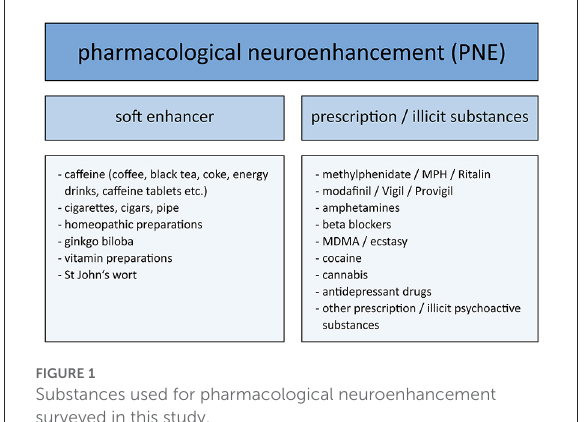
FIGURE1 Substances used for pharmacological neuroenhancement surveyed in this